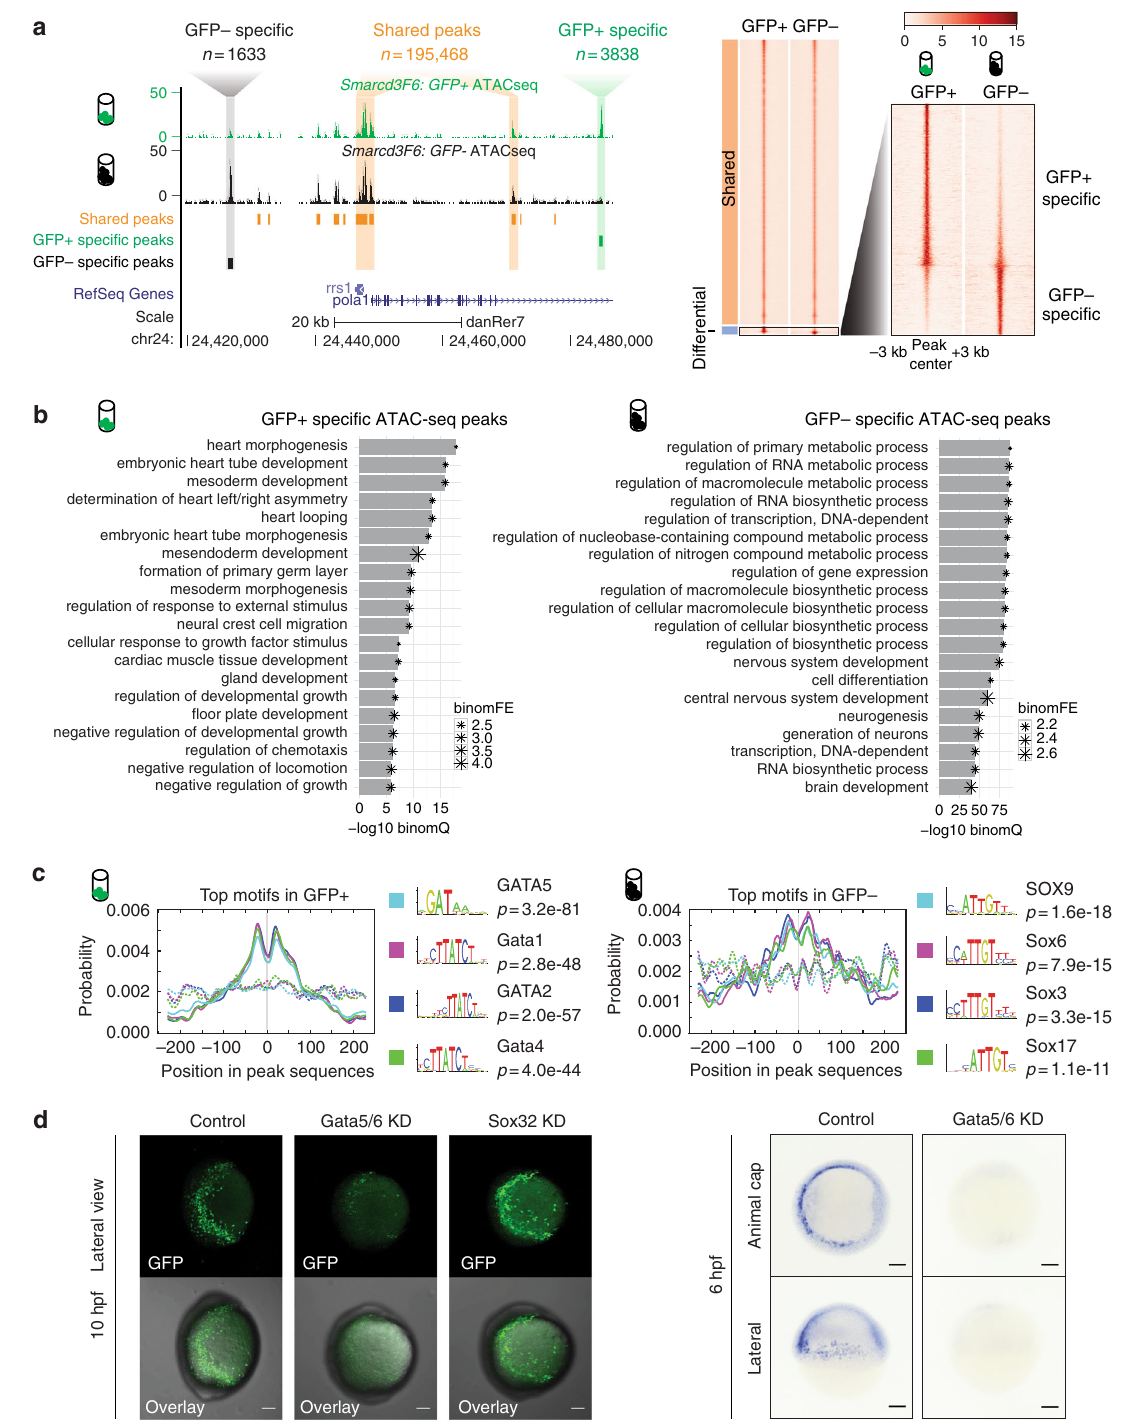
Fig. 2 Open chromatin landscape of Smarcd3 -F6 labeled population. a Genome browser view and heatmap showing ATAC-seq peaks shared between GFP + and GFP − populations or enriched in one population. In the heatmap, read intensity for regions within 3 kb of the peak center was plotted for each peak. b Barplot showing the 20 most enriched GO biological function terms obtained from GFP + / − speci fi c peaks using GREAT analysis. c Probabilities of the top 4 enriched motifs within the GFP + / − speci fi c peaks calculated by CentriMo 76 . Each curve shows the probability of the best match to a given motif occurring at a given position in the input sequences. Solid lines represent probabilities calculated from query peak sets (GFP + / − speci fi c peaks) while dash lines show that from the background sequences (shared peaks). d (Left) Confocal images of native GFP expression in control (uninjected), Gata5/6 KD (injected with Gata5/6 morpholinos) and Sox32 KD (injected with CAS morpholino) Tg(Smarcd3-F6: EGFP) transgenic embryos at 10 hpf; (Right) gfp in- situ on Tg(Smarcd3-F6: EGFP) embryos of 6 hpf that were uninjected (control) or injected with Gata5/6 morpholinos. All staining and imaging were performed under the same condition for the control and KD groups. All scale bars represent 100 μ